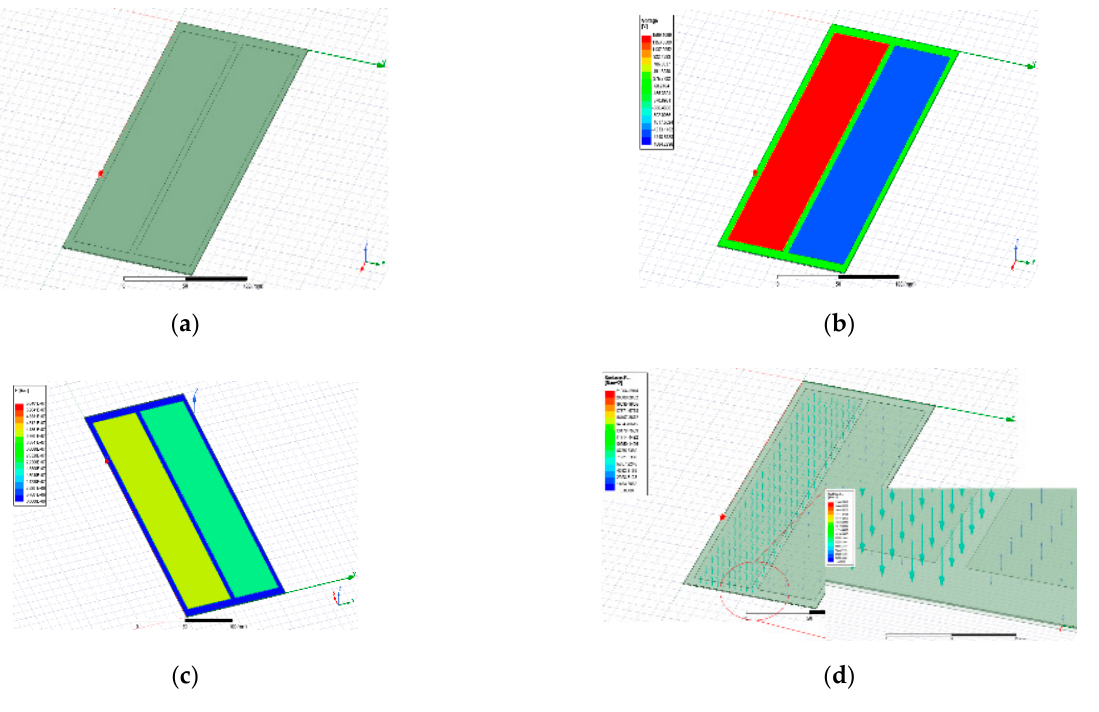
Figure 12. Optimal design electroadhesion pad FEM analysis result: ( a ) model design; ( b ) applied voltage; ( c ) electric field; ( d ) surface force density.